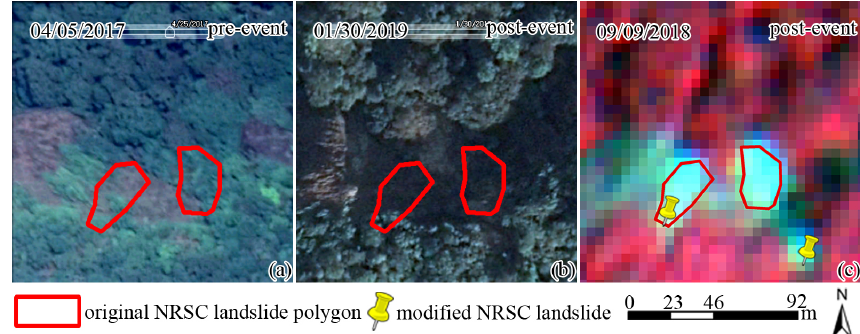
Figure 9. Example of the presence of dark shadows in the post-event images in Google Earth images making it impossible to check the orig- inal NRSC landslide polygons: (a) pre-landslide Google Earth image, (b) earliest available post-landslide Google Earth image in which the landslide cannot be recognized, and (c) mapping of the landslide initiation point based on Resourcesat-2 LISS-IV image (RGB combination: near infrared, red, green). Basemap data for (a) and (b) © Google Earth